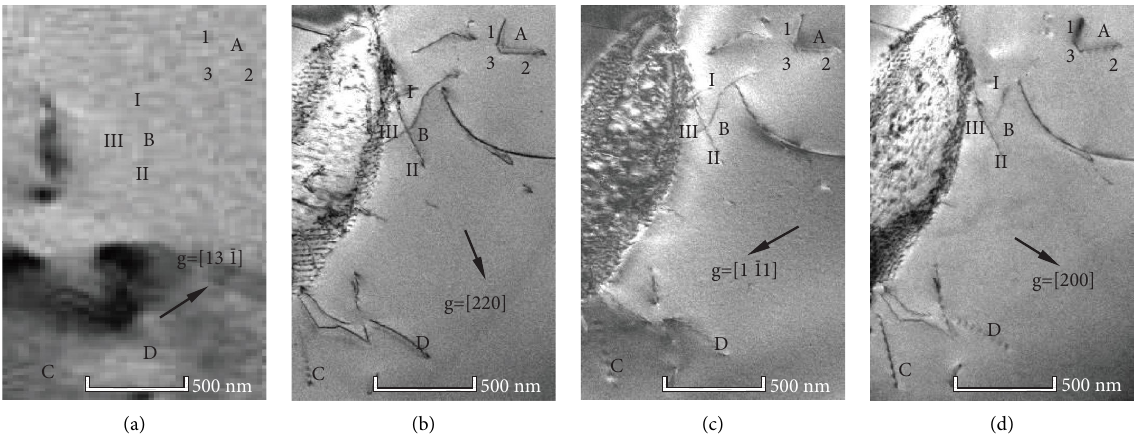
Figure 5: Dislocation confguration after the creep fracture at 1040 ° C/137MPa: (a) g � [ 13 ‾ 1 ] , (b) g � [ 220 ] , (c) g � [ 1 ‾ 11 ] , and (d) g � [ 200 ] .